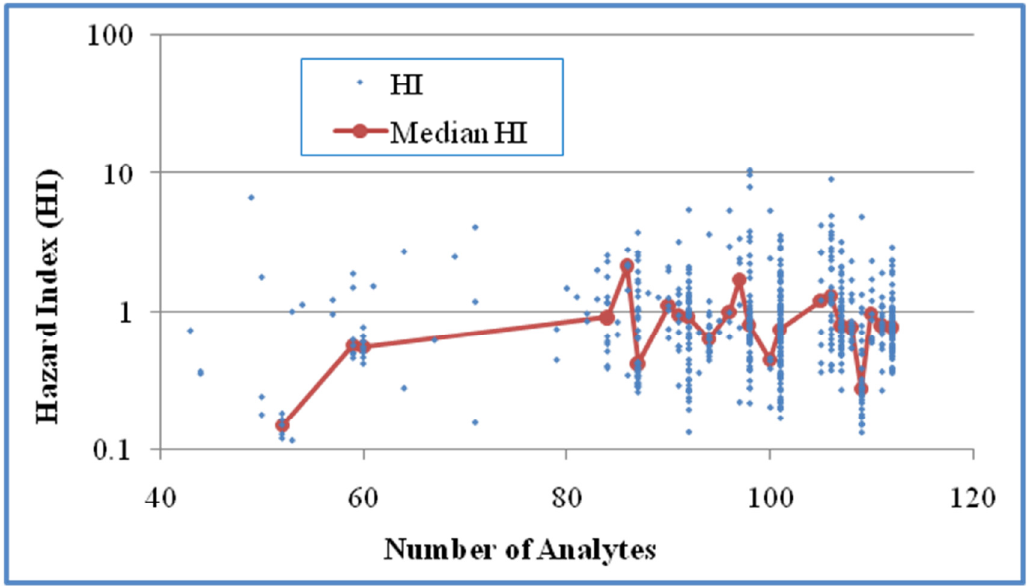
Figure 4. The relationship between HI and the number of analytes in the samples for Case 2 (618 mixtures). No statistical significance was shown for this correlation either based on all samples (Kendall’s τ = 0.0196 and p > 0.05) or median HI of grouped samples for groups with at least five values (τ = 0.0554 and p >